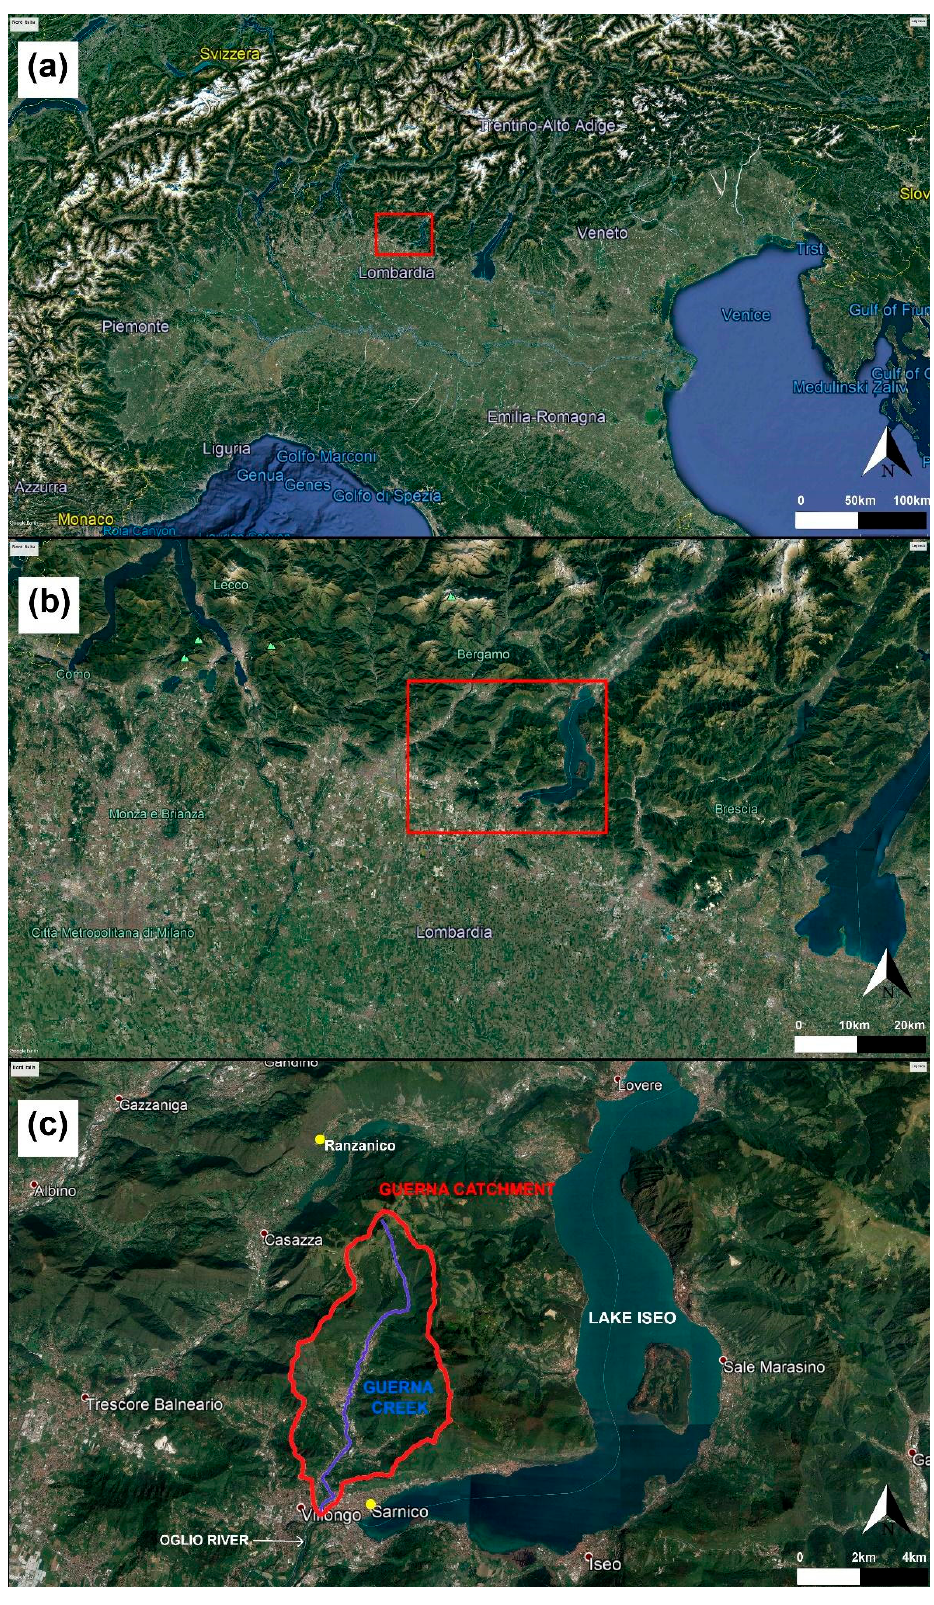
Figure 1. Territorial framework (base map from Google Maps, accessed May 2020): ( a ) background of the Italian Alps with identification of Guerna catchment and its surroundings, ( b ) Northern Italy with identification of Guerna catchment and its surroundings, ( c ) Guerna catchment location).